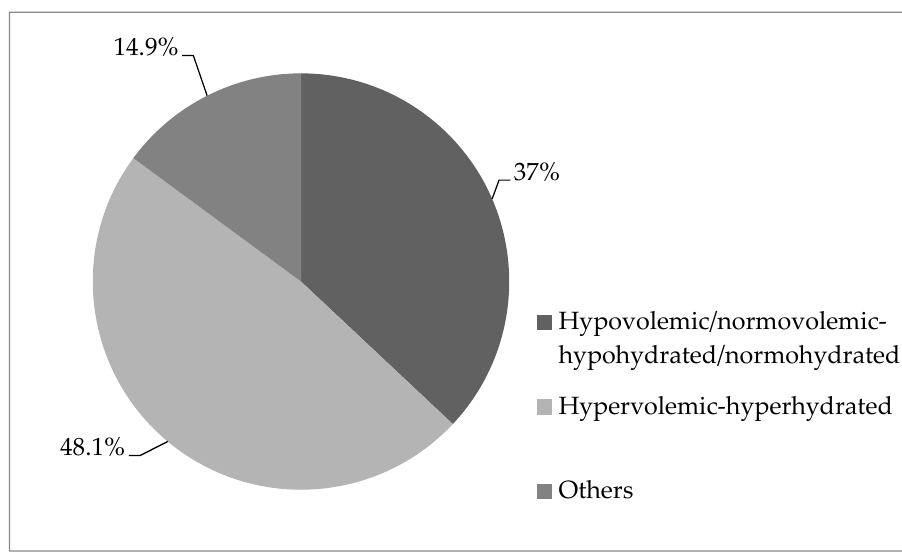
Figure 2. The percentage distribution of the patients according to volemia and hydration in the group of nonsurvivors.